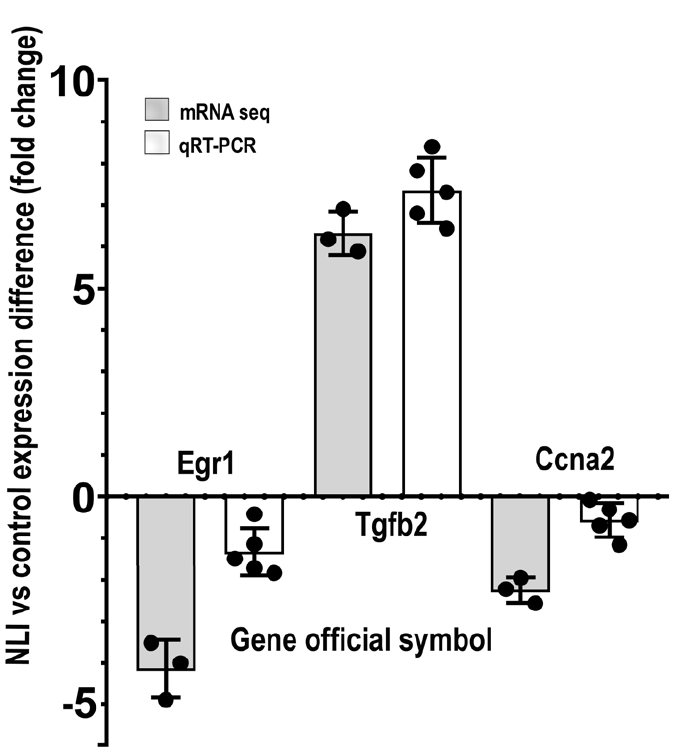
Figure 9. Validation of mRNA − seq data by qRT − PCR for Egr1, Tgfb2 and Ccna2. The bars represent mean values; the error bars show confidence intervals (CI), p = 0.95; the points represent separate values. The figure illustrates concordance between the data on the experiment vs. the control gene expression difference obtained with the mRNA − seq and qRT − PCR. The significance level for differences is p < 0.05 at least (Mann − Whitney and t − test).